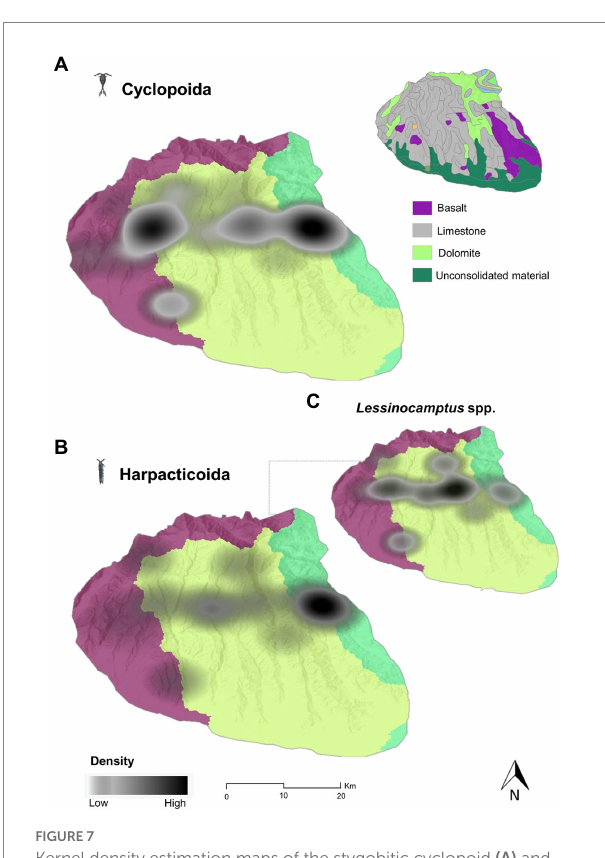
FIGURE 7 Kernel density estimation maps of the stygobitic cyclopoid (A) and harpacticoid (B) copepods species richness across the Lessinian Massif, with a focus on the harpacticoid genus Lessinocamptus (C) . The different colours of the base map layer represent the three distinct drainage basins (Western Lessini in purple, Lessinian Core in light green, and Eastern Lessini in bright